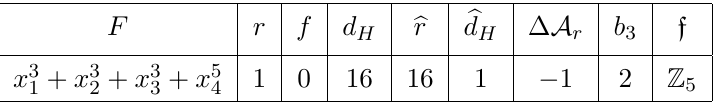
Table 6 . The SCFT data associated to the singularity x 3